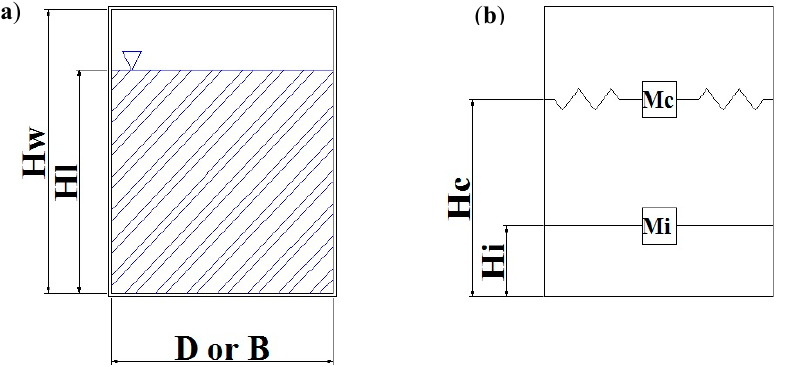
Figure 1. Schematic view of partially liquid-filled container: ( a ) internal profile of the tank; ( b ) impulsive and convective components.